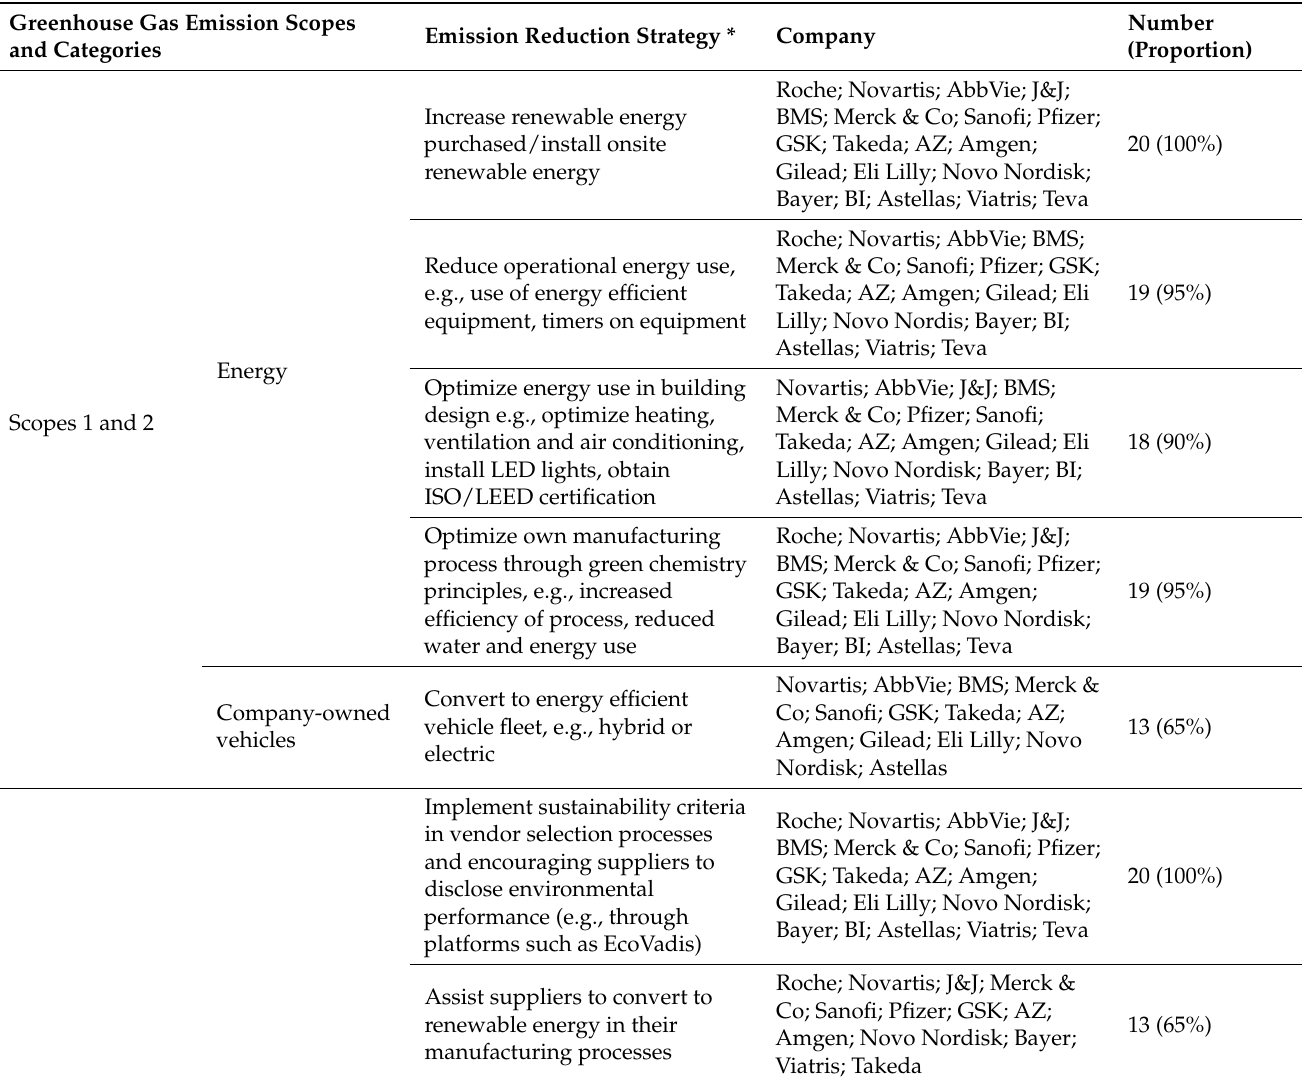
Table 2. Emission reduction strategies reported by all 20 pharmaceutical companies to reduce scope 1, 2, and 3 greenhouse gas